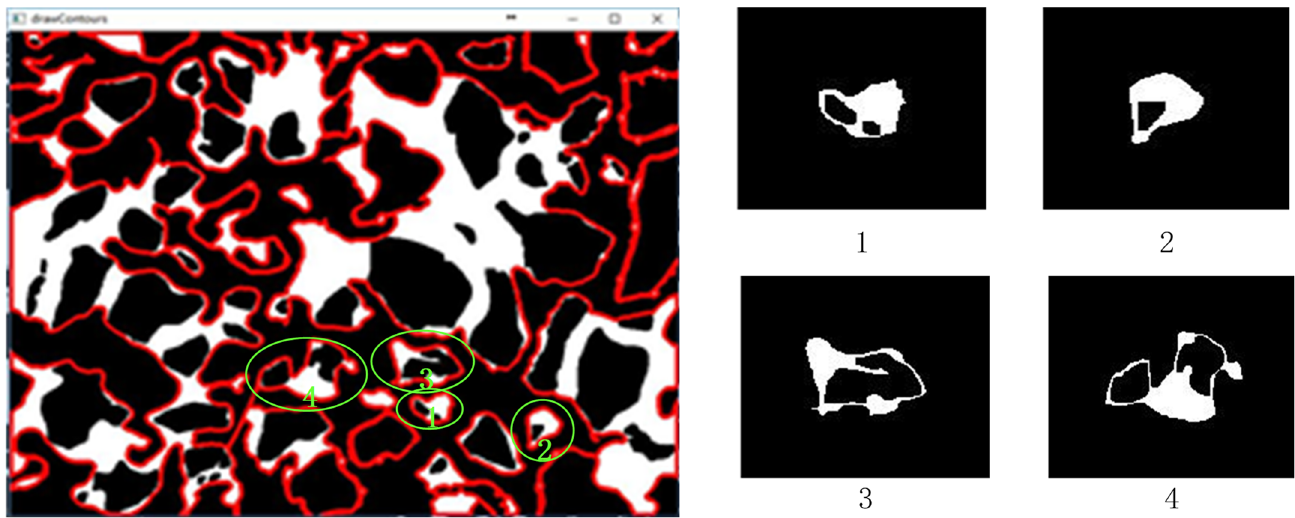
Figure 6. Extracting outline and cutting effect diagram.